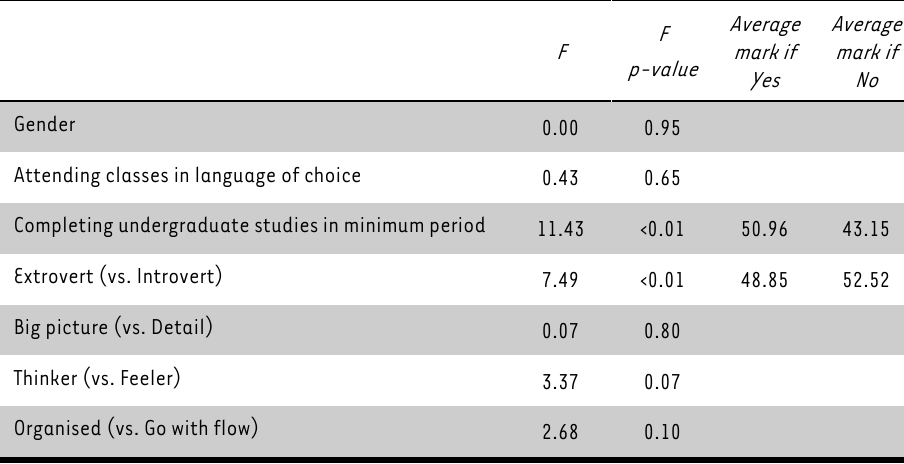
TABLE 3: Influence on mark obtained in CTA